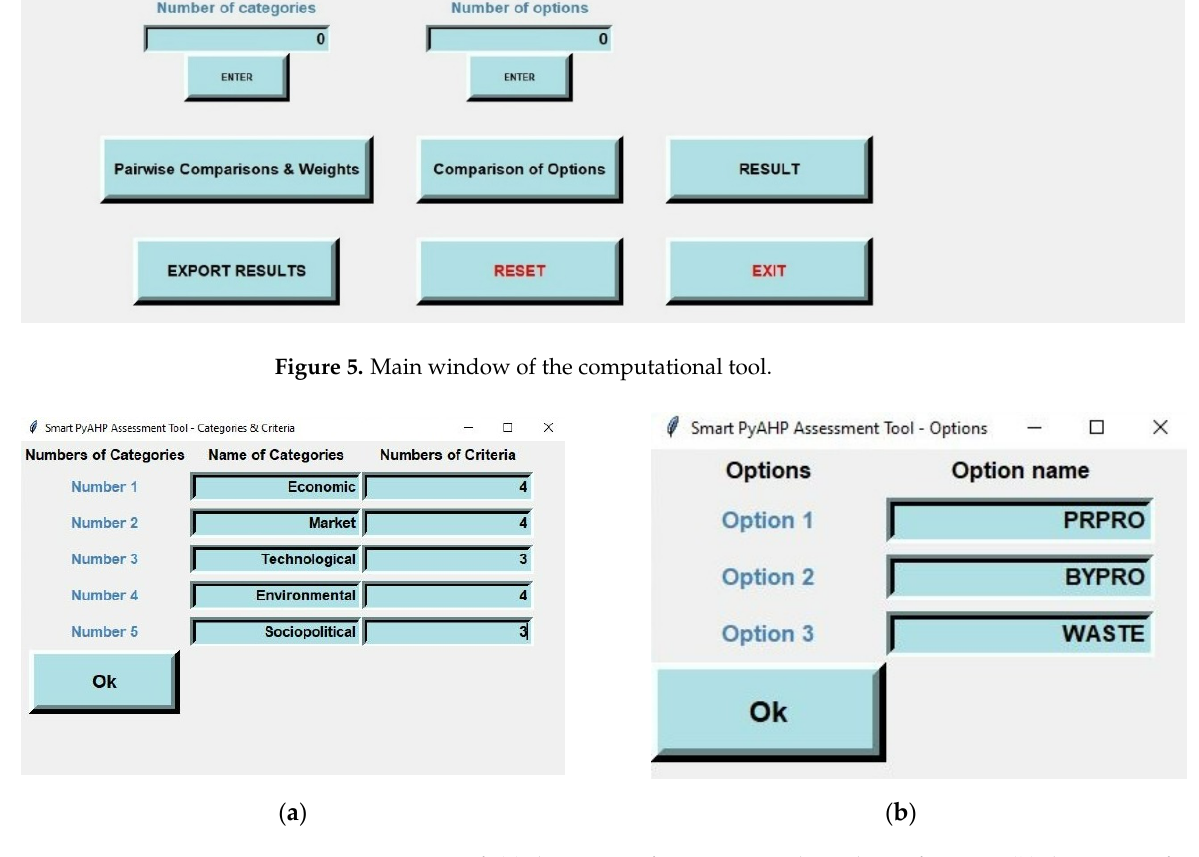
Figure 6. Insertion of: ( a ) the names of categories and numbers of criteria; ( b ) the names of options.